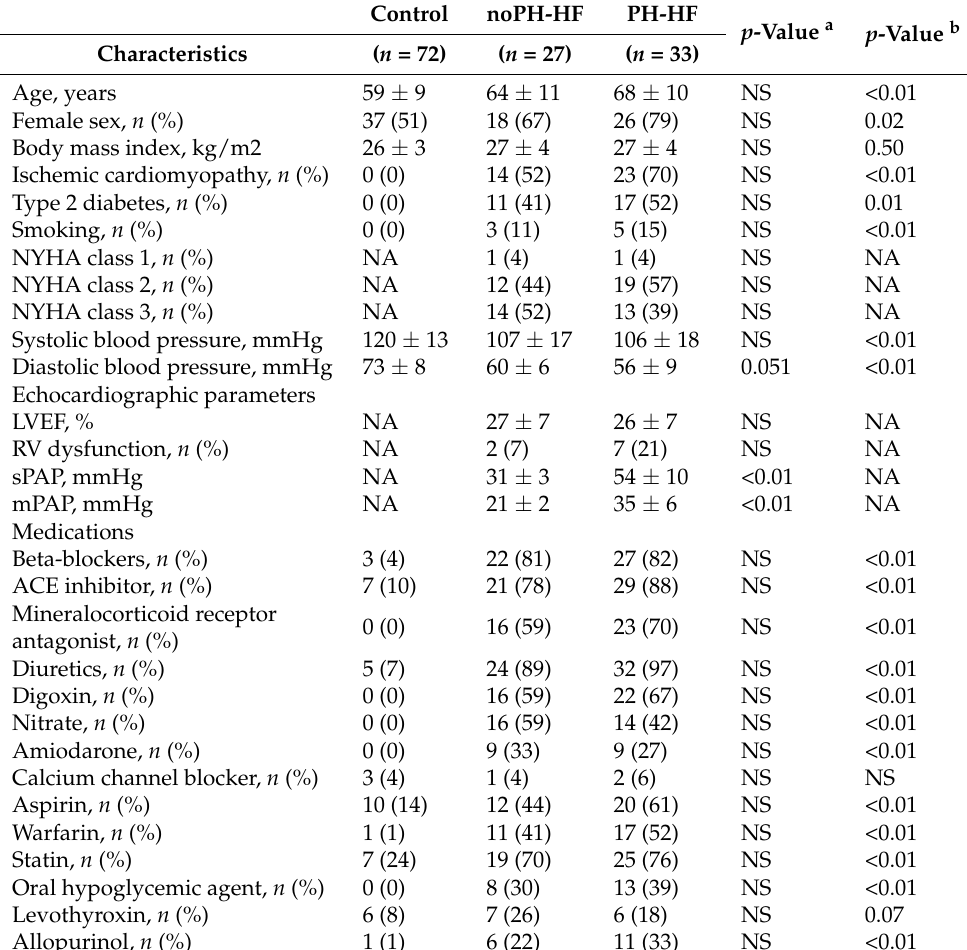
Table 1. Baseline characteristics by heart failure and pulmonary hypertension